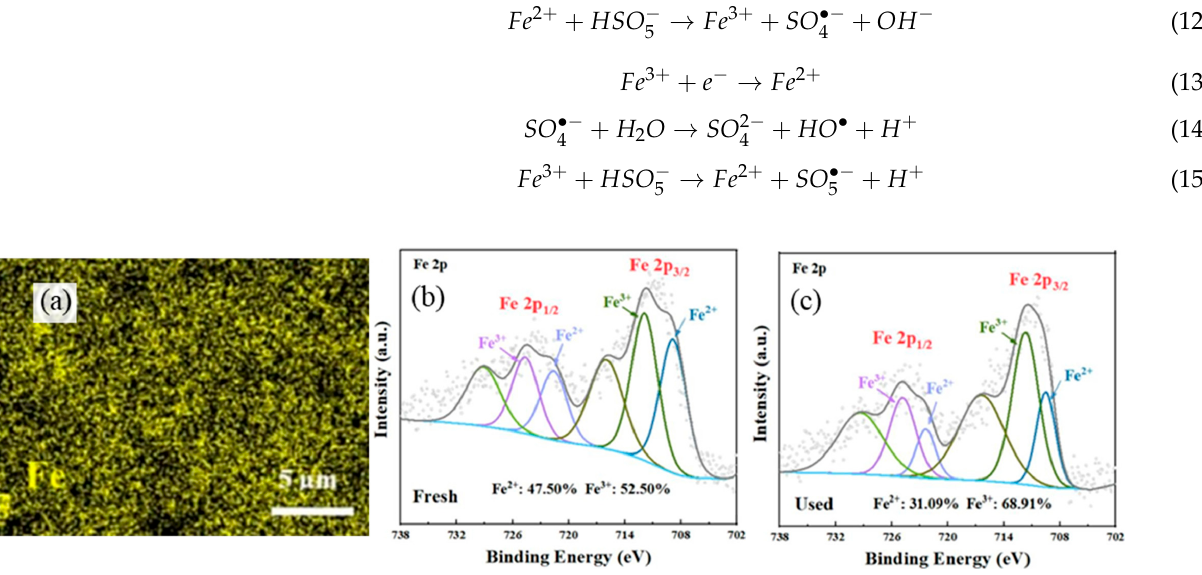
Figure 4. ( a ) The Fe element mapping of ISBC; ( b ) Fe 2p XPS spectra of fresh ISBC; ( c ) Fe 2p XPS spectra of ISBC used for 4 cycles in ISBC/PMS system [74], copyright 2022, Elsevier.